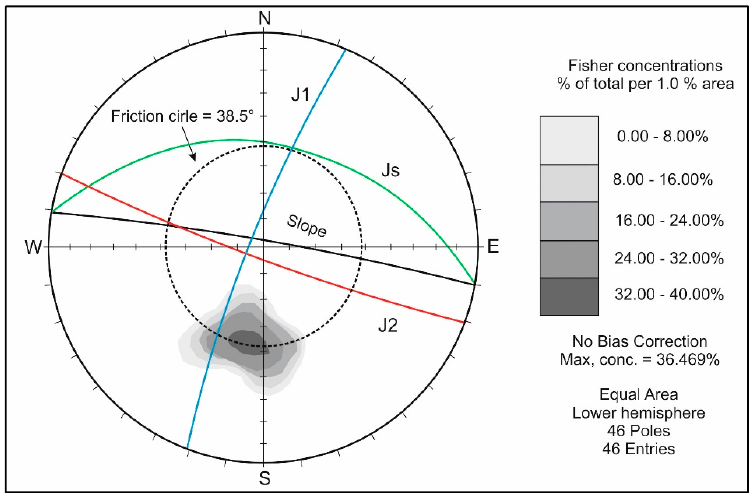
Figure 6. Kinematic stability analysis for potential plane failures along the Js joint set performed by means of the software program DIPS.